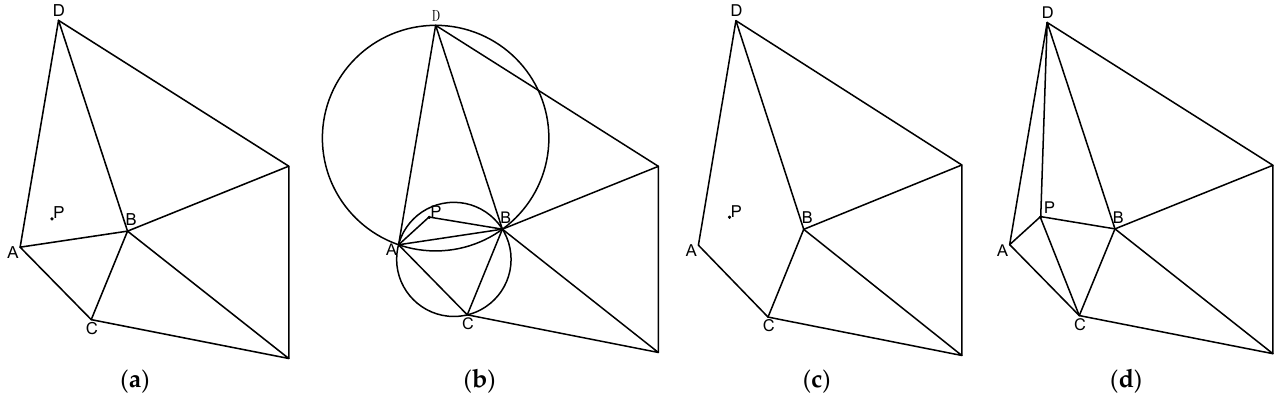
Figure 9. The key step 2 of the Bowyer–Watson algorithm. ( a ) Insert new node P; ( b ) decide how to connect P with other vertices; ( c ) delete edge AB; ( d ) form a triangle.